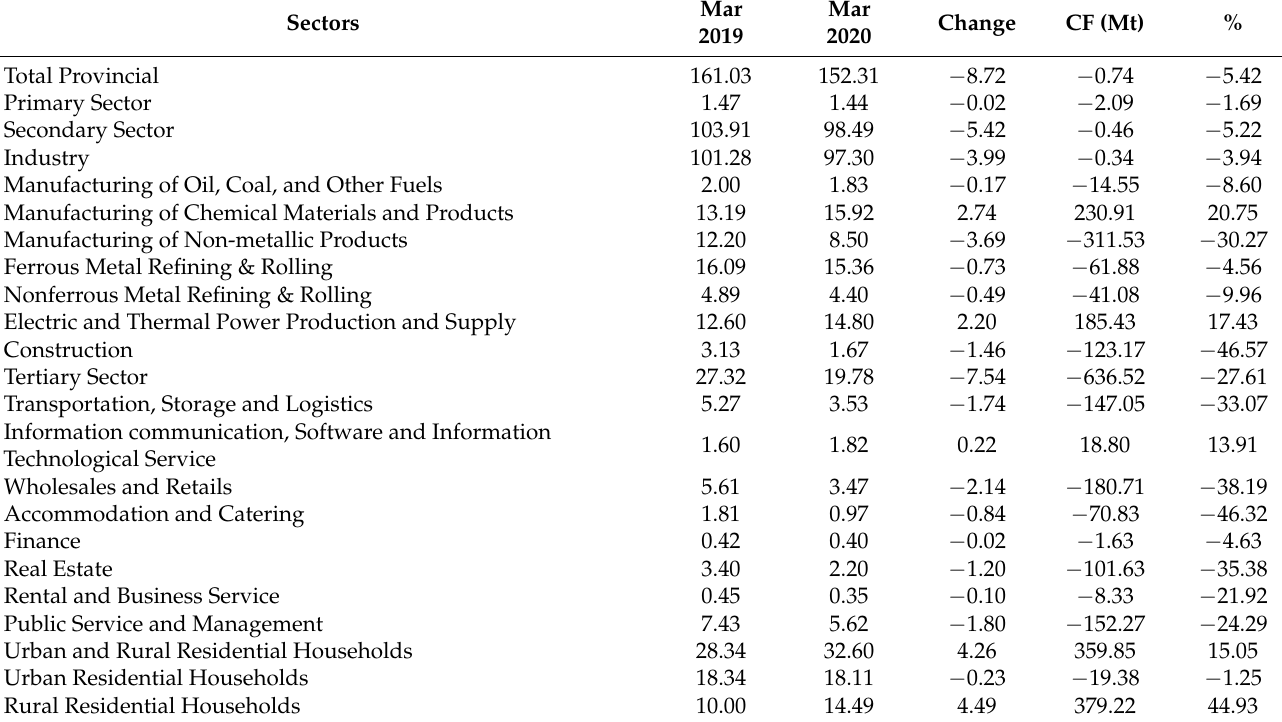
Table 9. Hubei sectoral carbon footprint changes of April 2020 compared to April